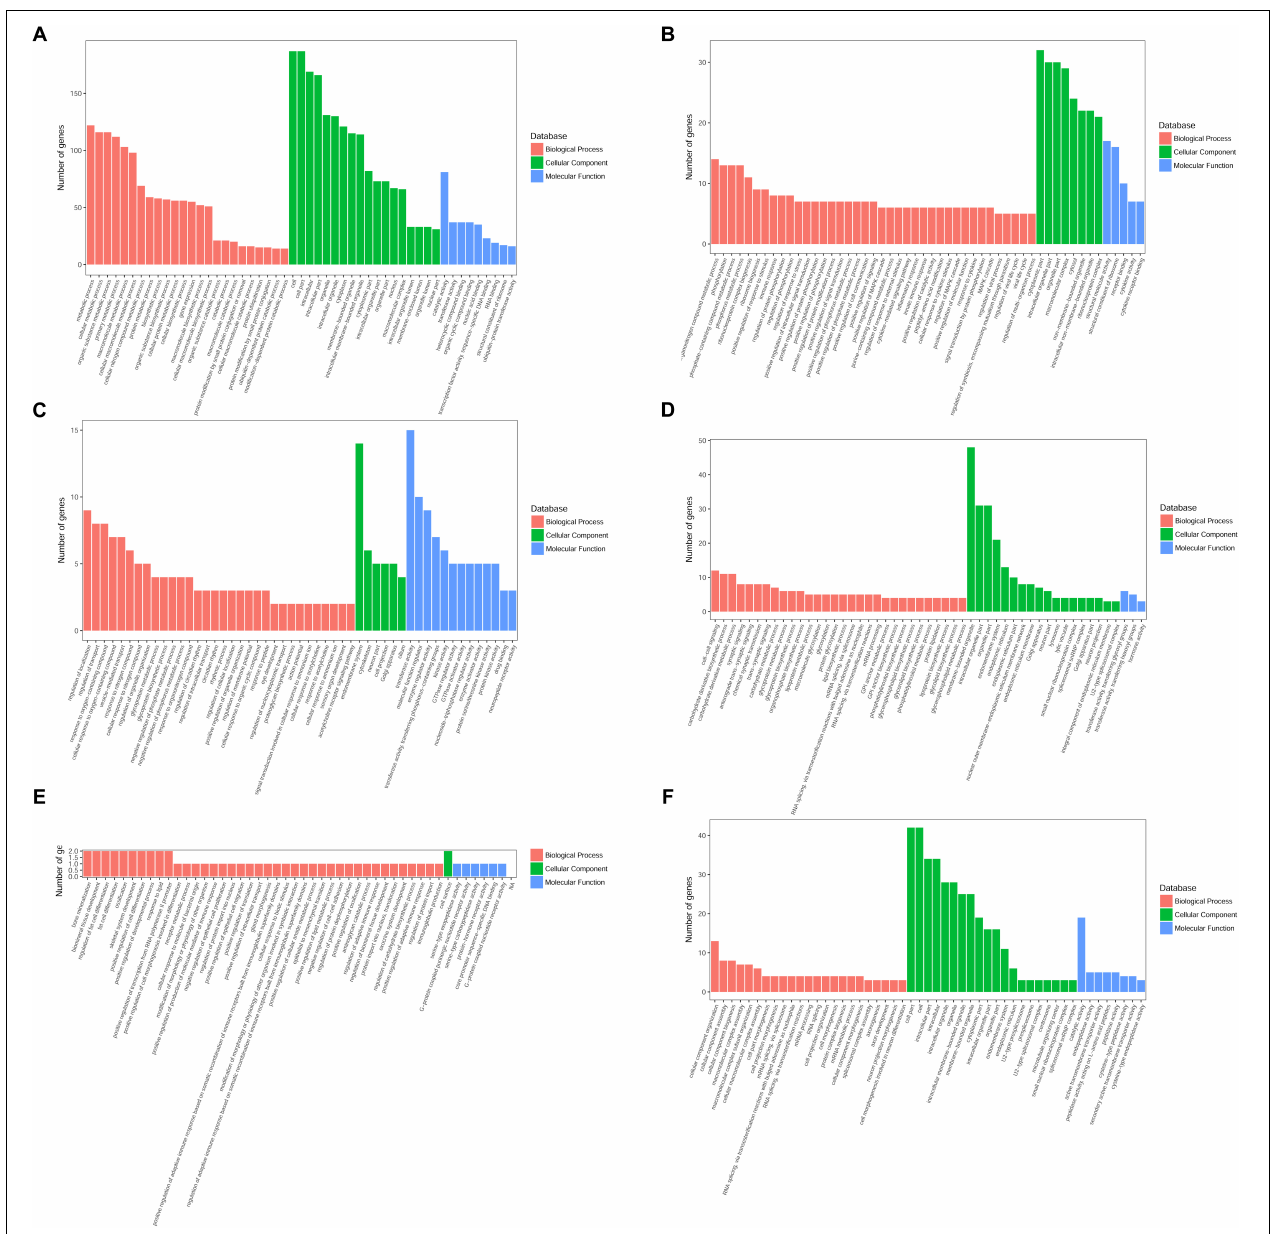
FIGURE 4 | GO annotation analysis of upregulated and downregulated DEGs at various time points. GO annotation characterization of the molecular functions, biological processes, and cellular components based on significantly upregulated or downregulated DEGs. (A) GO annotation for upregulated DEGs at 6 h. (B) GO annotation for downregulated DEGs at 6 h. (C) GO annotation for upregulated DEGs at 12 h. (D) GO annotation for downregulated DEGs at 12 h. (E) GO annotation for upregulated DEGs at 24 h. (F) GO annotation for downregulated DEGs at 24